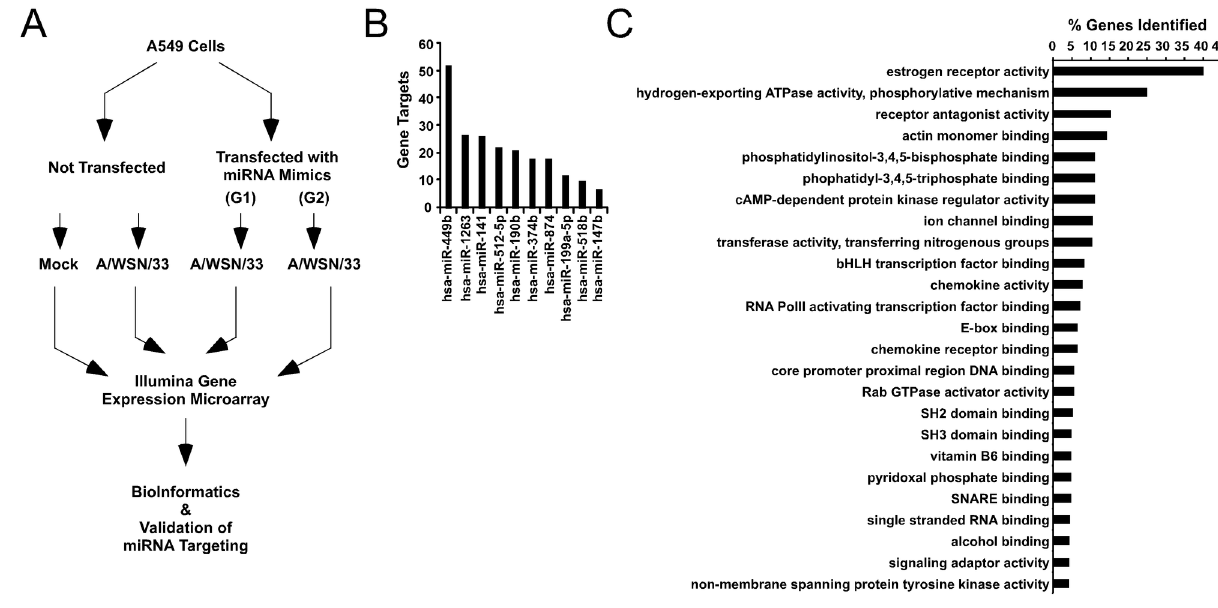
Figure 3. MicroRNA regulation of cellular mRNAs during influenza virus infection. (A) A549 cells were mock infected, infected with A/WSN/33 (5 pfu/cell), or infected after transfection with an equimolar mixture of miRNAs (50nM final concentration) that included either hsa-miR-141, hsa-miR-374b, hsa-miR-449b, hsa-miR-518b, and hsa-miR-1263 (G1), or hsa-miR-147b, hsa- miR-190b, hsa-miR-199a-5p, hsa-miR-512-5p, and hsa-miR-874 (G2). Gene expression profiling was performed by microarray analysis. Genes that exhibited greater than 1.5 fold expression difference and a p-value less than 0.05 were further analyzed. (B) Number of significantly decreased genes that contain a binding site for the indicated miRNA within the 3’ UTR. (C) Molecular function GO terms were identified for down regulated genes based on a literature search with key words “ homo sapiens ,” “infection,” “virus,” and “immunity” to identify known protein interactions with miRNA regulated genes. Histogram depicts the percent of genes identified associated with the indicated GO